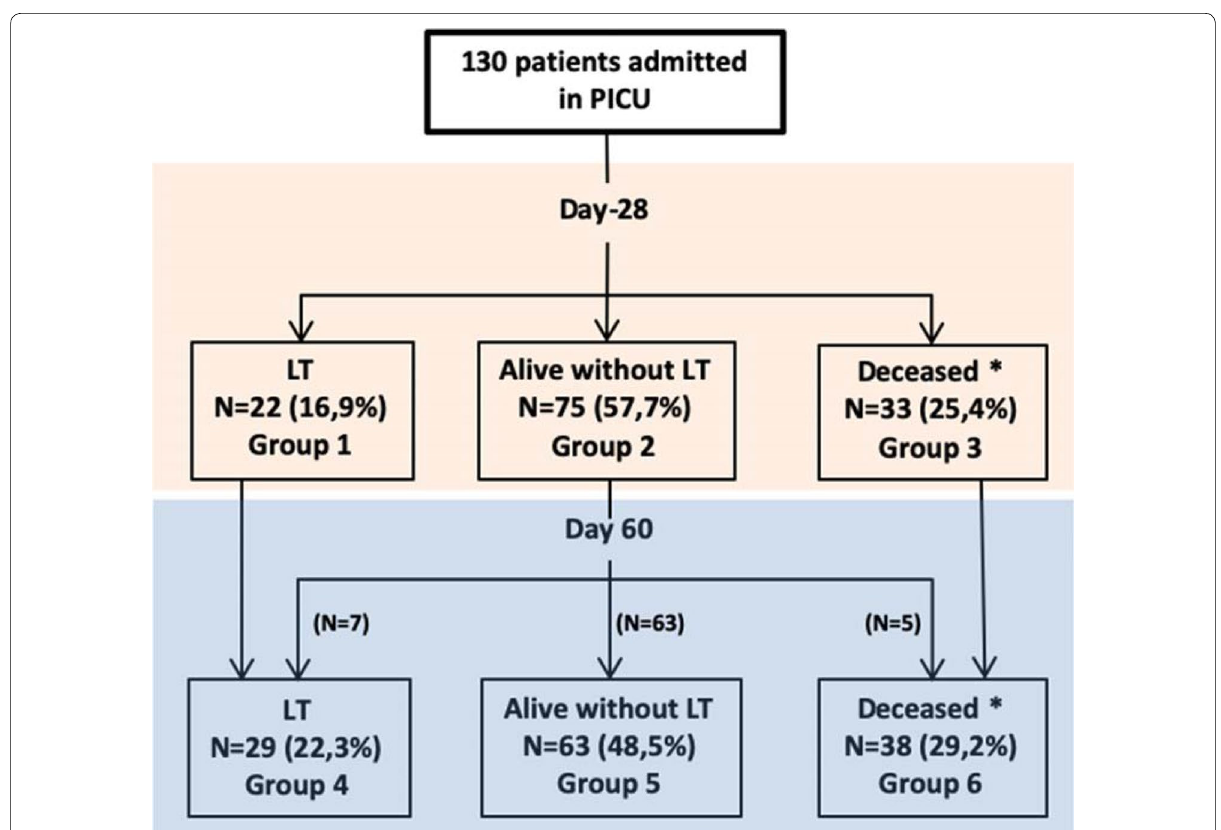
Fig. 1 Flowchart of the 130 children with acute decompensated chronic liver disease admitted in PICU and outcomes analysis. *No death in liver transplanted patients. Outcome analysis: primary outcome: group 1 versus group 2; secondary outcome 1: group 4 versus group 5; secondary outcome 2: group 3 versus group 2; secondary outcome 3: groups 4 6 versus group 5. LT, liver +